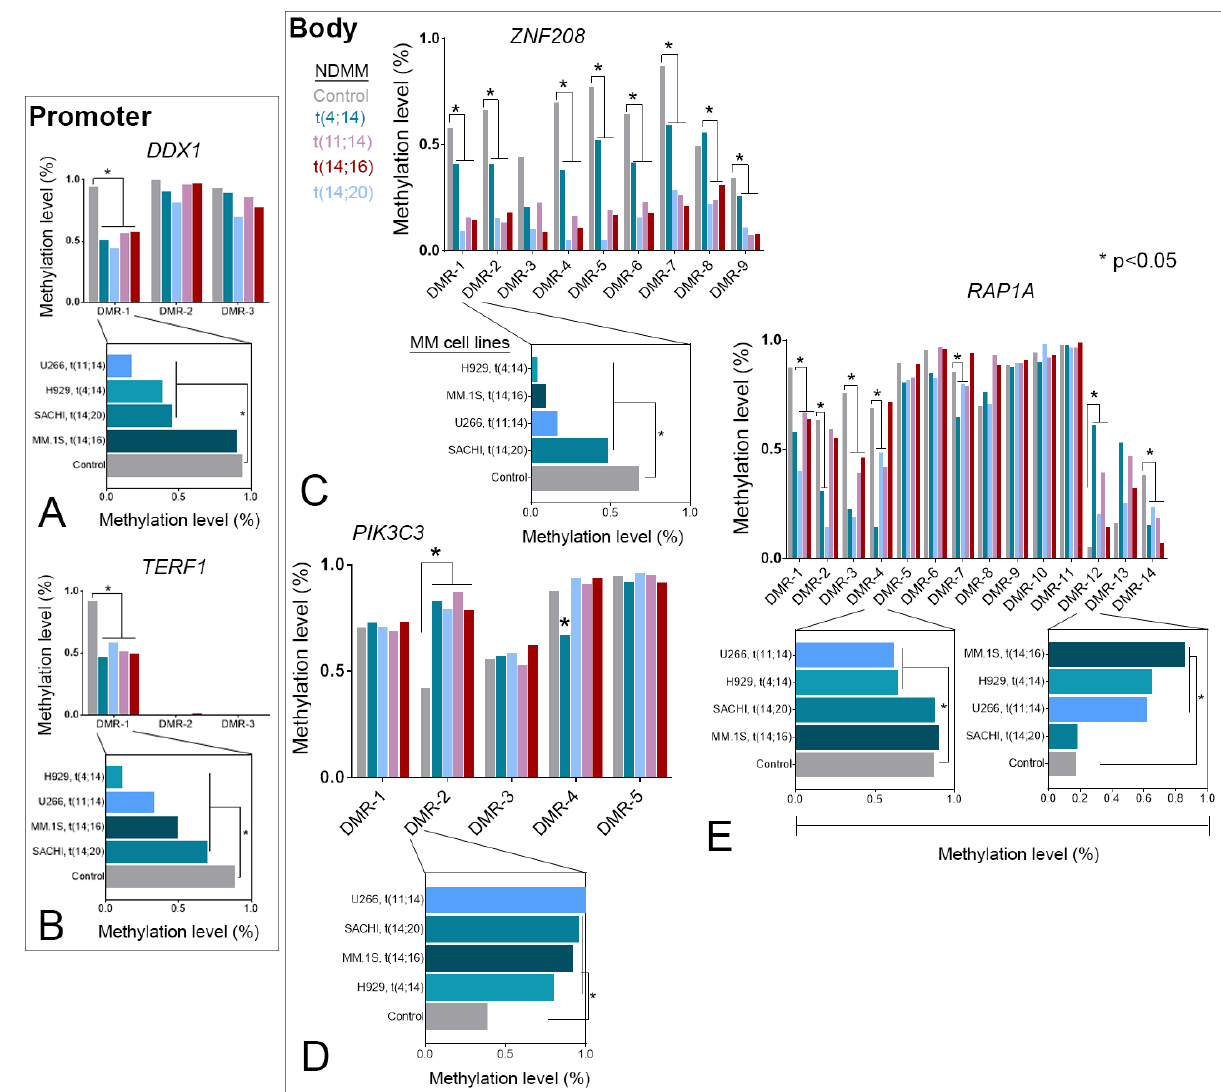
Figure 4. We observed similarities in DNA methylation pattern across DMRs of representative TRGs between NDMM subgroups and MM cell lines. For instance, DMR-1 at the promoters of ( A ) DDX1 and ( B ) TERF1 , and DMRs at the bodies of ( C ) ZNF208 , and ( E ) RAP1A were hypomethylated. We observed a single (DMR-2; p < 0.05) hypermethylated DMR at the body of PIK3C3 ( D ). Abbreviations: DMR, differentially methylated regions; NDMM, newly diagnosed multiple my- eloma; TRG, telomere-related gene.